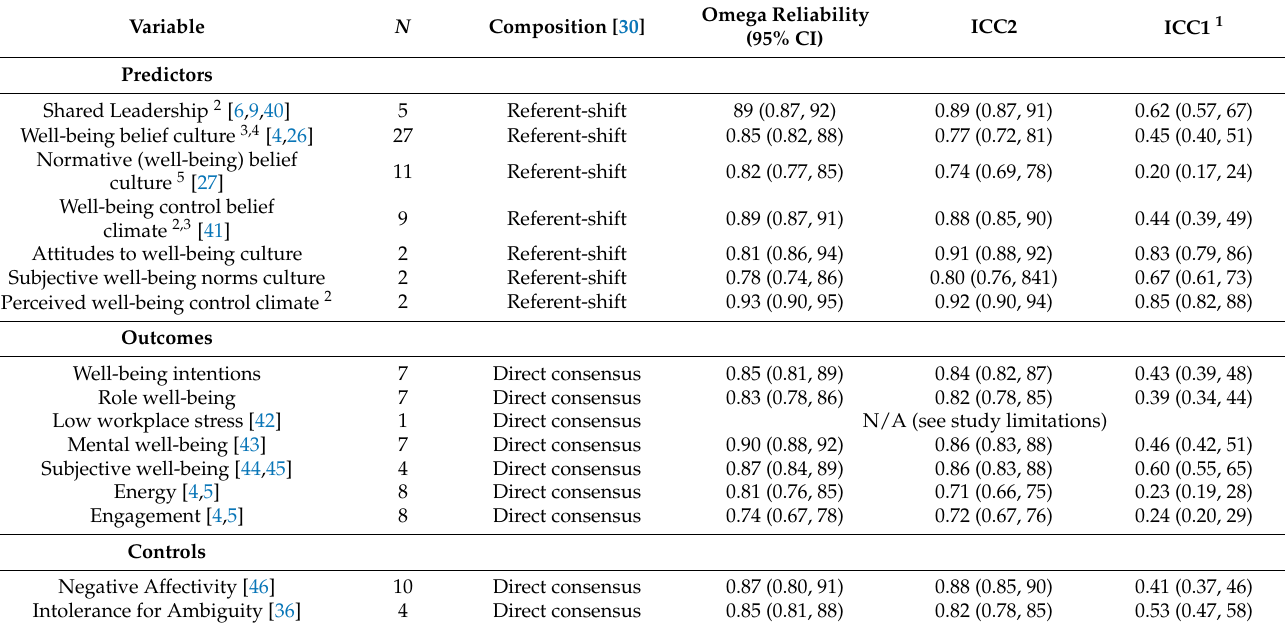
Table 2. Summary of variables and their